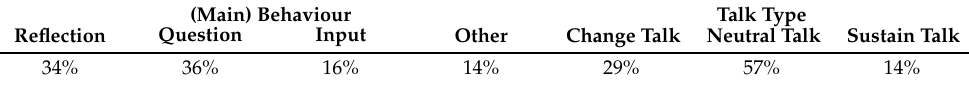
Table 14. Distribution of (Main) Behaviour and Talk Type after de-duplication. Overall, (Main) Behaviour has 3796 unique examples and Talk Type has